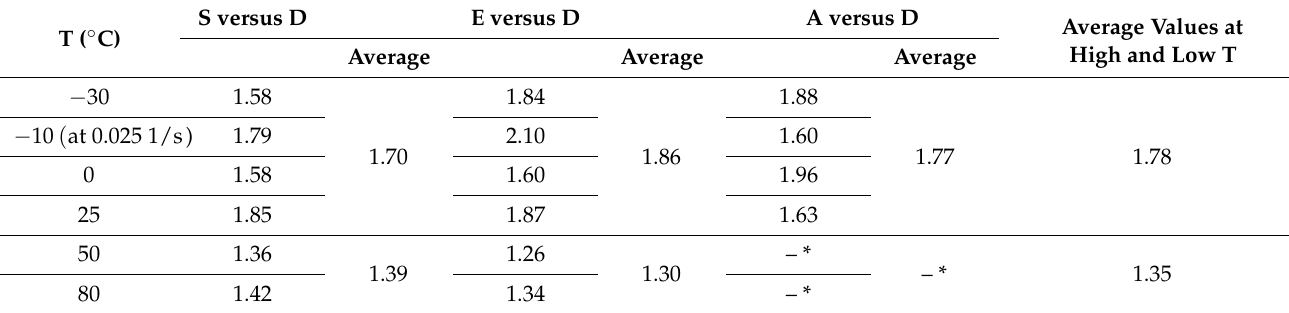
Table 3. Calculated values of γ at different